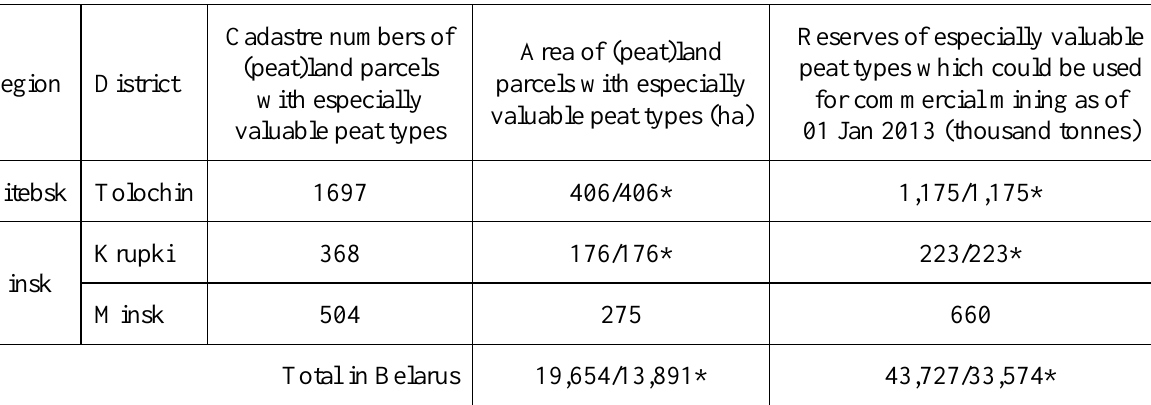
Table A2.4. Example data per district for (peat)land parcels with especially valuable peat types; in this case as raw material for bitumen production.